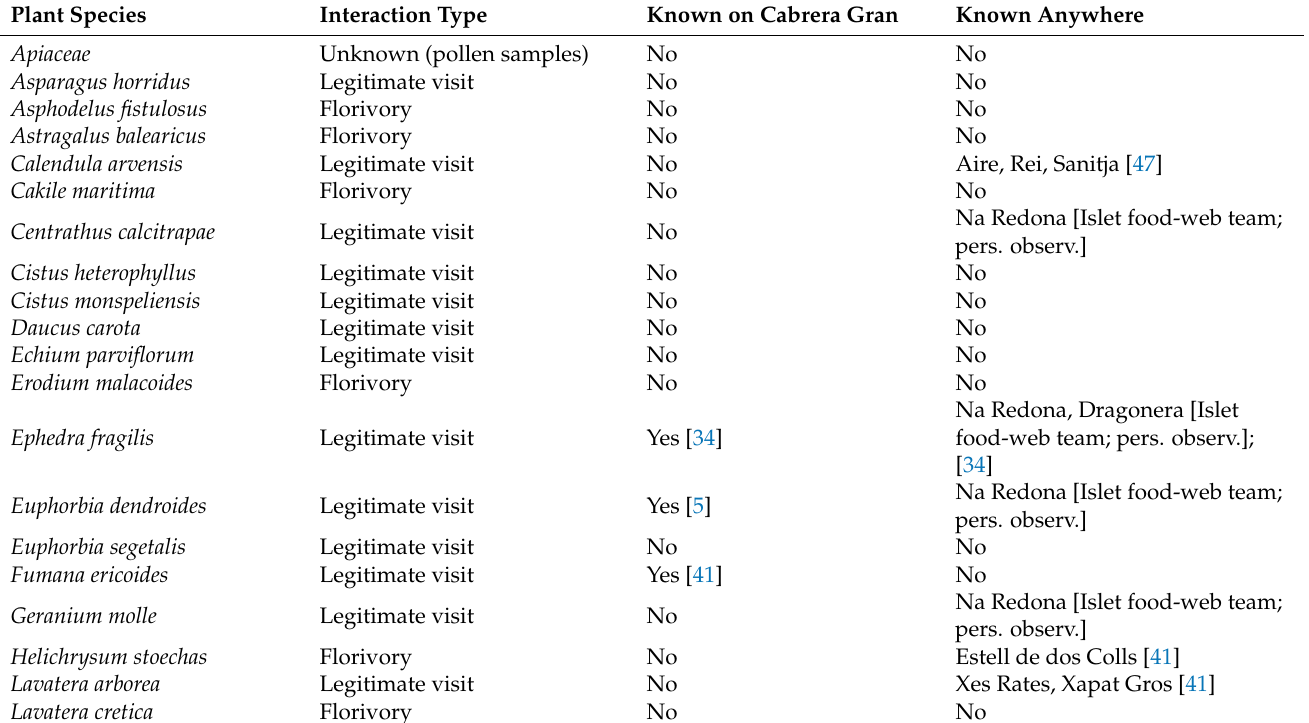
Table 1. Interactions between the Balearic lizard ( Podarcis lilfordi ) and flowers observed from 5 April to 6 May 2022 on Cabrera Gran (Balearic Islands). Note: four morphospecies found in pollen samples could not be